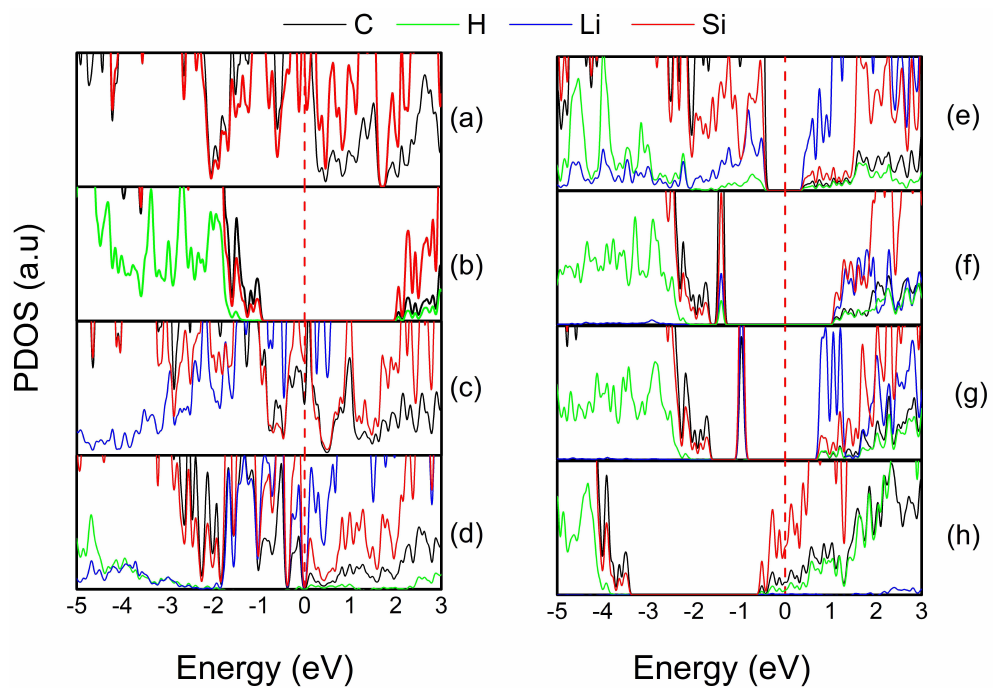
Figure 4. Partial Density of States of 3C-SiC (1 1 0) surfaces. ( a ) Pristine, ( b ) Full-H, ( c ) Full-Li,